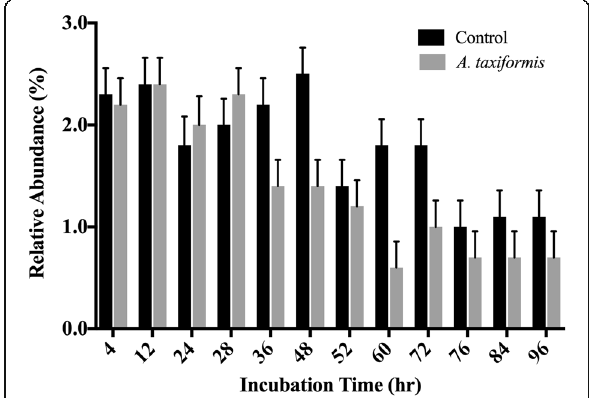
Fig. 6 Relative abundance of Euryarchaeota during in-vitro fermentation. Fermentations were performed in three in-vitro vessels (n = 3). Error bars indicate standard error of the